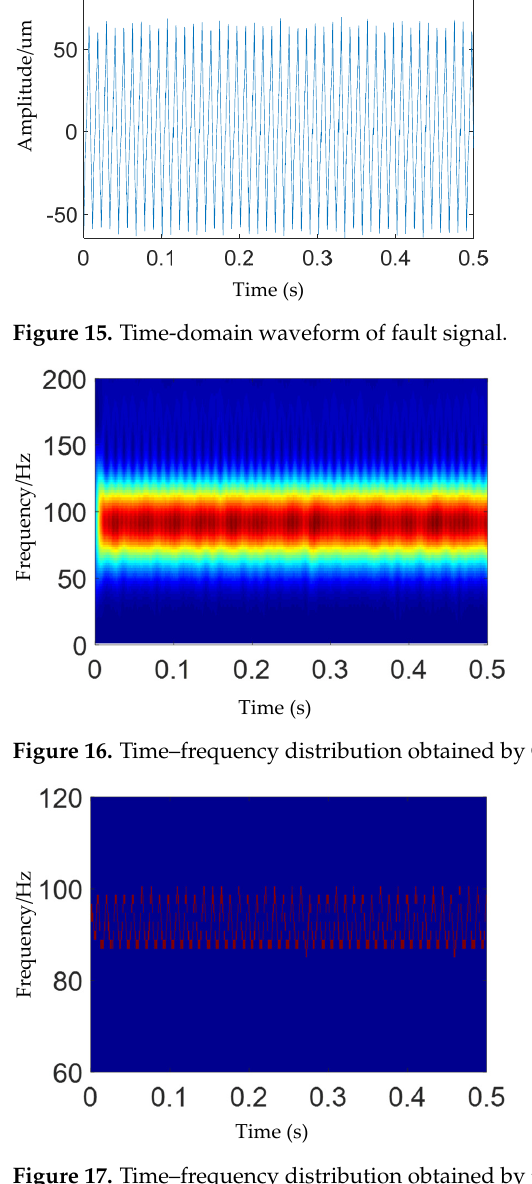
Figure 18. Time – frequency distribution obtained by the RSECT. From Figure 16, although the GLCT extracts the faulty feature frequency, the resolu- tion of the features in the time and frequency domains is obviously unsatisfactory and needs further improvement. From Figures 17 and 18 both the SET and RSECT can clearly extract the fault feature frequency of 90Hz with better resolution in both time and fre- quency domains, which has obvious advantages. Comparing Figures 17 and 18, the RSECT retains the advantages of the SET, thus further improving the time–frequency res- olution and the smoothness of the time–frequency features. the effectiveness of the pro- posed RSECT is further verified. To further verify the effectiveness, the proposed method is applied to the analysis and processing of the rubbing test data of the double-disk rotor. The rotor experimental stage is illustrated in Figure 19a. The rotor is driven by an electric motor and the bearings are sliding bearings. The vertical and horizontal vibrations are measured by a non-contact eddy current sensor. The rubbing rotor test bench is shown in Figure 19b. motor